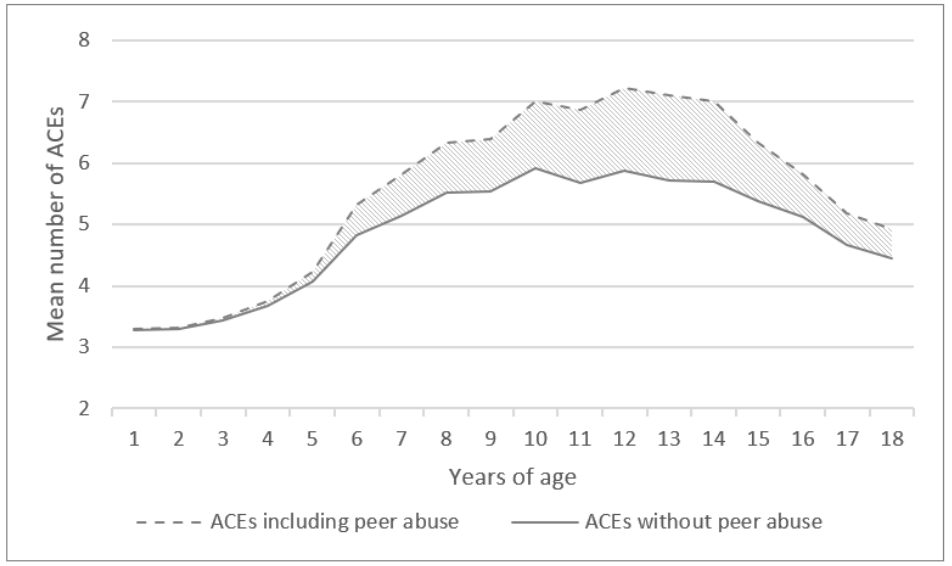
Figure 1. Mean number of Adverse Childhood Experiences (ACEs) per age year for patients with at least one form of ACE; hatched area marks the increase in ACEs when peer abuse is considered.